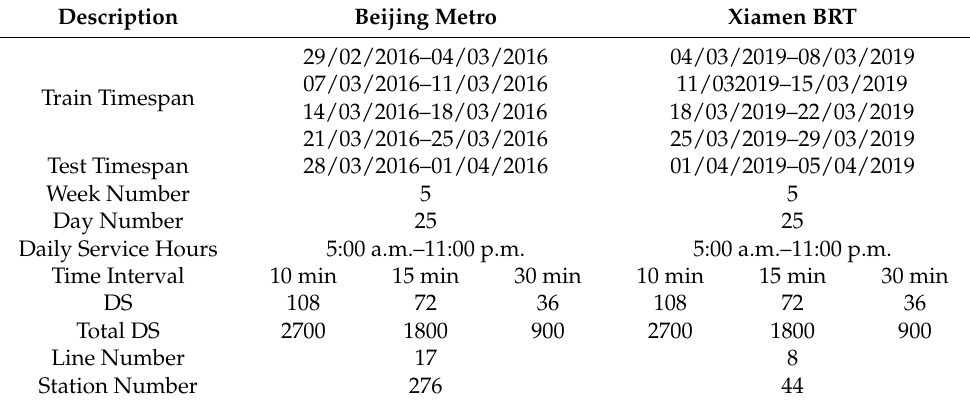
Table 1. Dataset Description.